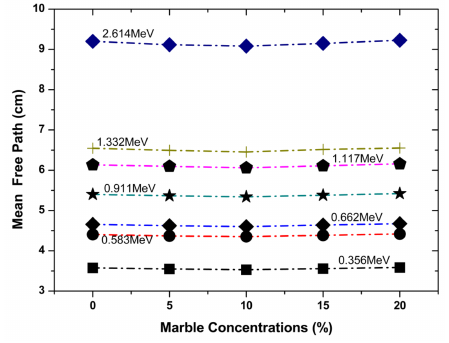
Figure 5: The effective atomic number, Z eff , as a func- tion of the incident photon energy.